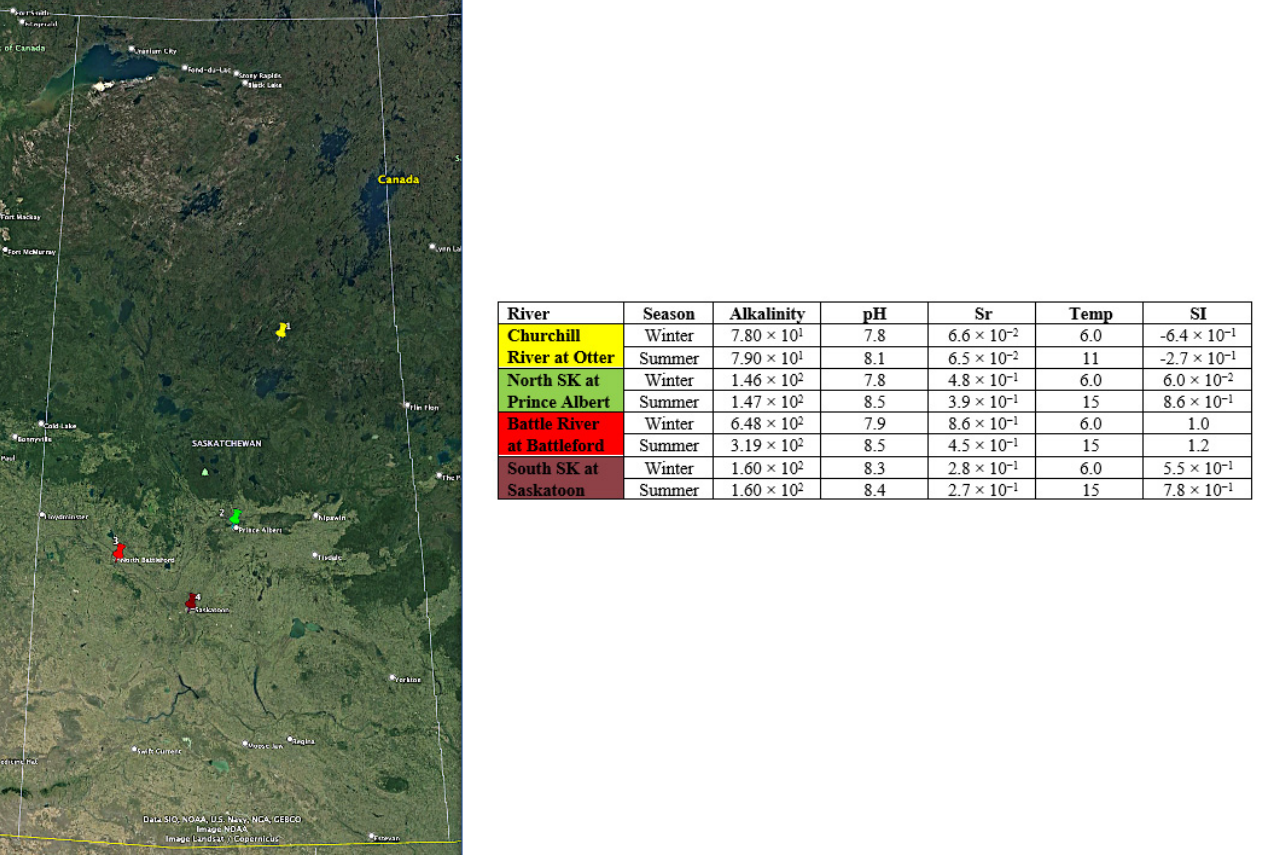
Figure 2. Selected Water Security Agency of Saskatchewan stations where the CCPP tool and strontium precipitation potential were estimated using winter and summer datasets. Map pin colour matches table background colour (i.e., the yellow pin is the monitoring station on the Churchill River). The Churchill River was sampled at Otter Rapids, the North Saskatchewan River at the City of Prince Albert water treatment plant intake, the Battle River at Battleford Rapids, and the South Saskatchewan River near the city of Saskatoon [24].